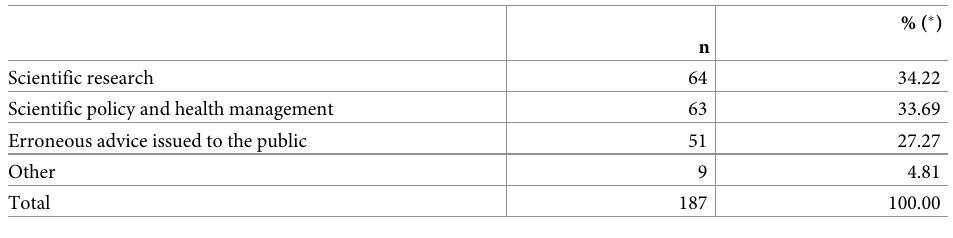
Table 6. Content of science and health-related